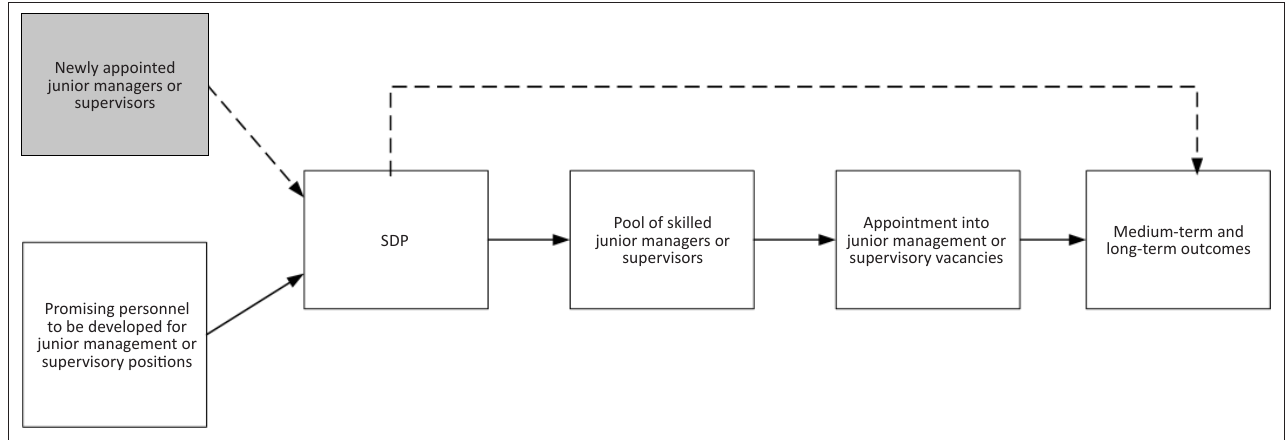
FIGURE 5: Revised programme theory of the supervisory development programme.